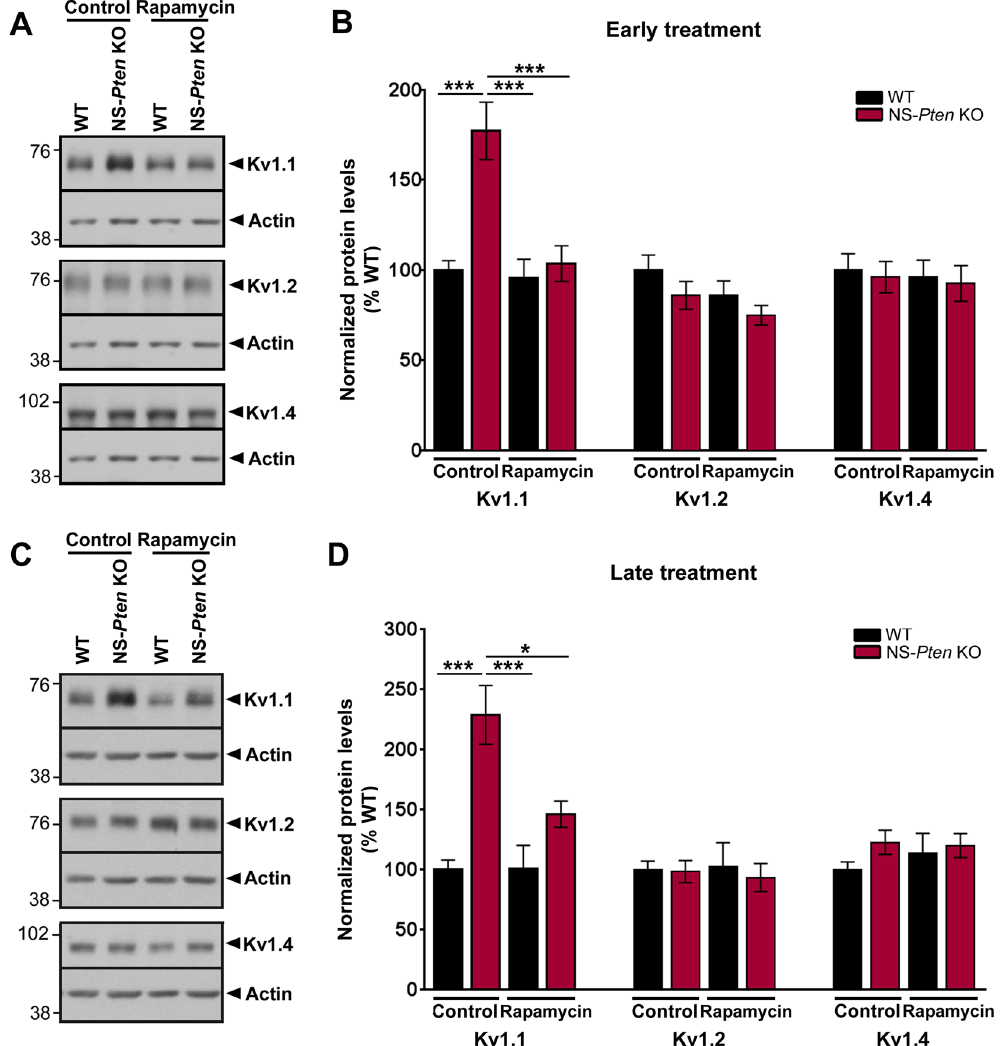
Figure 5. Rapamycin treatment normalizes Kv1.1 protein levels in NS- Pten KO mice. WT and NS- Pten KO mice were treated with vehicle or rapamycin (10 mg/kg i.p.) for 5 days per week for 2 weeks, either during postnatal weeks 4 and 5 ( A,B ; early treatment) or during postnatal weeks 9 and 10 ( C,D ; late treatment). Tissue was collected for western blotting one day after the last treatment. ( A ) Representative western blots from whole hippocampal homogenates from early control (naïve and vehicle-treated) and rapamycin-treated WT and NS- Pten KO mice probed with antibodies against Kv1.1, Kv1.2, Kv1.4, and actin are shown. Full-length blots are presented in Supplemental Fig. 2. ( B ) Quantification of western blots showed that Kv1.1 protein levels were significantly higher in NS- Pten KO compared to WT mice in the control group. Early rapamycin treatment suppressed Kv1.1 protein levels in NS- Pten KO mice to WT levels. No significant changes in Kv1.2 or Kv1.4 protein levels were found between NS- Pten KO and WT mice regardless of treatment group. n = 7–16 mice/group; *** p < 0.001 by one-way ANOVA with Tukey’s post-hoc test; errors bars are ± SEM. ( C ) Representative western blots from whole hippocampal homogenates from late control (naïve and vehicle-treated) and rapamycin-treated WT and NS- Pten KO mice probed with antibodies against Kv1.1, Kv1.2, Kv1.4, and actin are shown. Full-length blots are presented in Supplemental Fig. 2. ( D ) Quantification of western blots showed that Kv1.1 protein levels were significantly higher in NS- Pten KO compared to WT mice in the control group. Late rapamycin treatment suppressed Kv1.1 protein levels in NS- Pten KO mice to WT levels. No significant changes in Kv1.2 or Kv1.4 protein levels were found between NS- Pten KO and WT mice regardless of treatment group. n = 6–14 mice/group; * p < 0.05, *** p < 0.001 by one-way ANOVA with Tukey’s post-hoc test; errors bars are ±